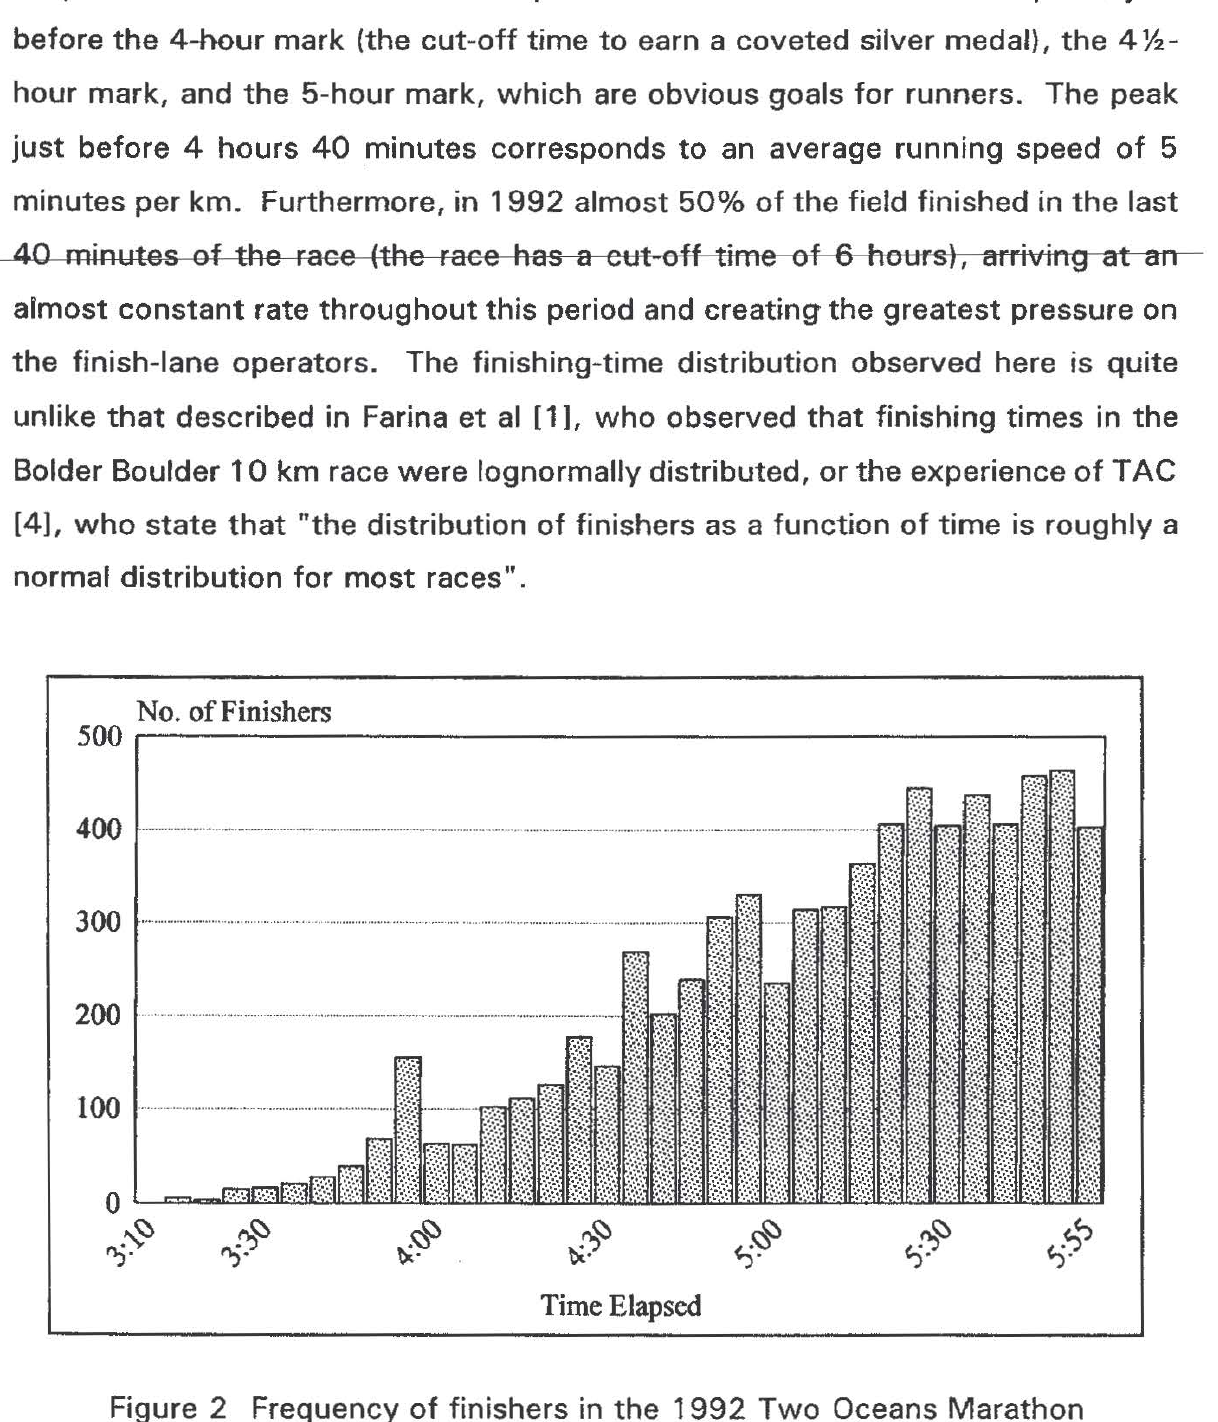
Figure 2 Frequency of finishers in the 1992 Two Oceans